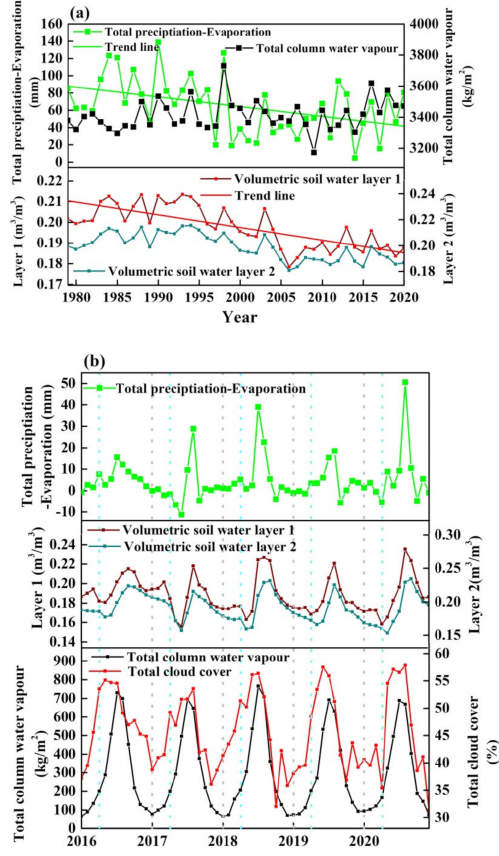
Figure 6. Temporal distribution of key water cycle parameters. We used the linear regression method to calculate trends. ( a ) Annual average parameter change curve and trend. ( b ) Monthly average parameters change curve. The grey dotted line is January, and the blue dotted line is April.